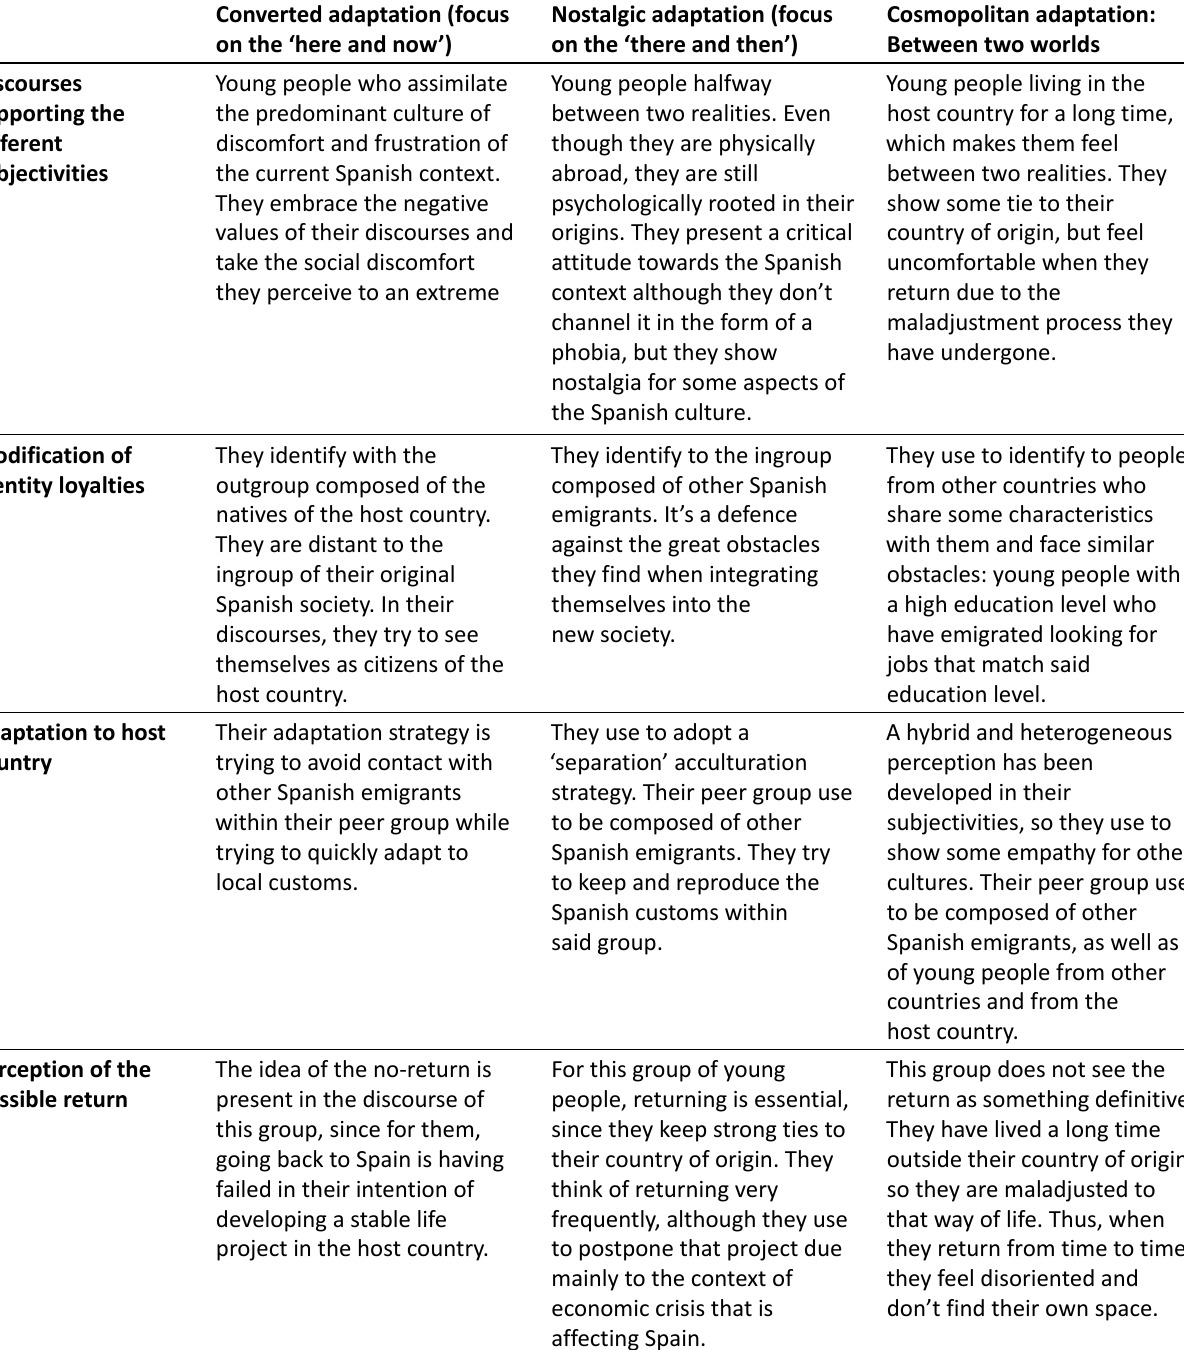
Table A1. Young migrants’